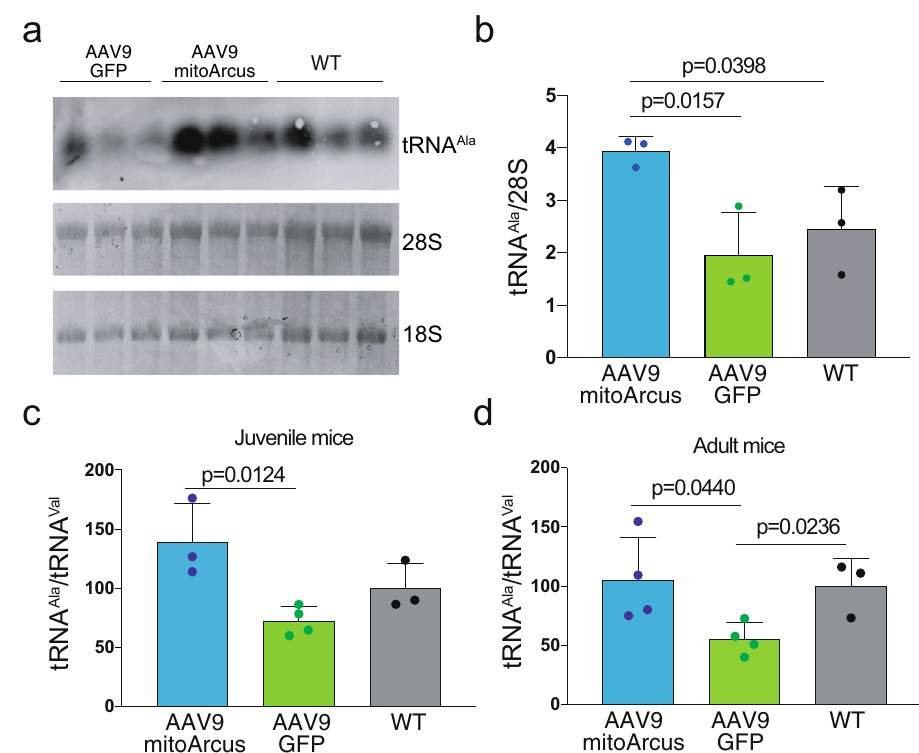
Fig. 5 mitoARCUS-induced increase in mt-tRNA Ala in the liver. a Northern blot analysis of juvenile mouse liver 24 weeks PI probed for mt-tRNA Ala and total RNA loading (28S and 18S). b Quanti fi cation of mt-tRNA Ala (from panel a) normalized to 28S rRNA ( n = 3). Riboruler high-range molecular marker was used, but the lowest marker was 200 nt, whereas the tRNA are ~75 nt. c Quanti fi cation of mt-tRNA Ala by qPCR compared to levels of mt-tRNA Val in juvenile mouse liver 24 weeks PI. RNA samples from AAV9-mitoARCUS-treated animals compared to AAV9-GFP controls and WT liver samples ( n = 3 with the exception of GFP n = 4). d Quanti fi cation of mt-tRNA Ala compared to levels of mt-tRNA Val in adult mouse liver. RNA samples from AAV9- mitoARCUS-treated animals compared to AAV9-GFP controls and WT liver samples, at 24 weeks PI ( n = 4 with the exception of WT n = 3). Data are mean ± SEM. Statistical analysis was performed using two-tailed Student ’ s t